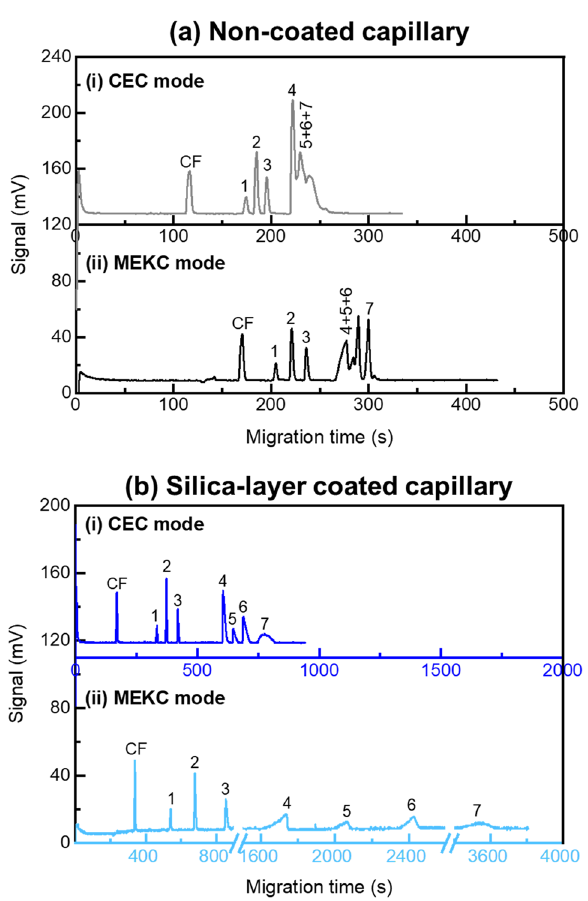
Fig. 1 Electropherograms of caffeine and seven standard phenolic acids using a fused-silica capillary and b silica-layer coated capil- lary. (i) CEC mode. (ii) MEKC mode. Sample: 100 µM caffeine (Peak CF), 200 µM PHPA (Peak 1), 50 µM PCA (Peak 2), 100 µM PHBA (Peak 3), 200 µM CFA (Peak 4), 200 µM DHPA (Peak 5), 200 µM GLA (Peak 6), and 200 µM THBA (Peak 7) (abbreviations as given in Table 2). The separation parameters are: running buffer: 25.0 mM borate buffer (pH 9.0) for CEC mode, addition of 50.0 mM SDS for MEKC mode; electrokinetic injection: 21,000 V for 3 s; field strength: 21,000 V; UV detection: 280